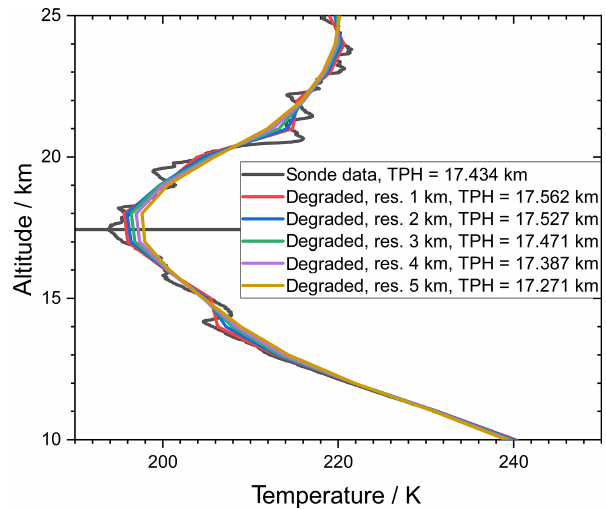
Figure 1. A radiosonde temperature profile measured at Nairobi, 1.3 ◦ S, 36.8 ◦ E on 18 August 2010, 07:35UT, along with a set of degraded profiles (Gaussian kernel) with resolutions from 1 to 5km. The horizontal dark line indicates the original tropopause altitude. The inferred tropopause heights (TPHs) are reported in the